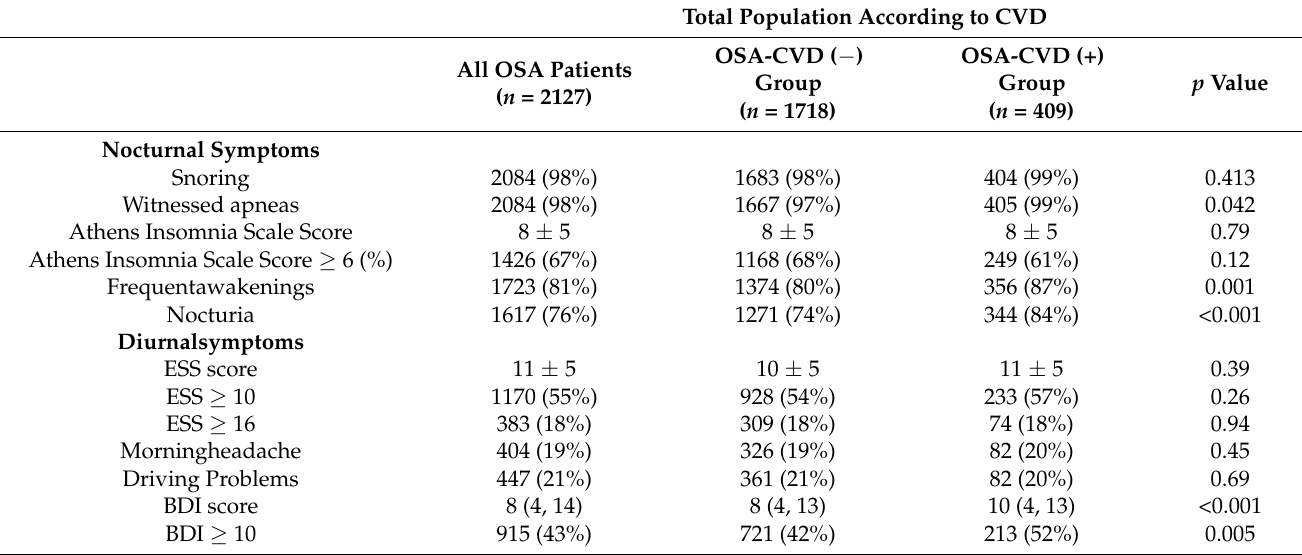
Table 3. Nocturnal and diurnal symptoms of the study